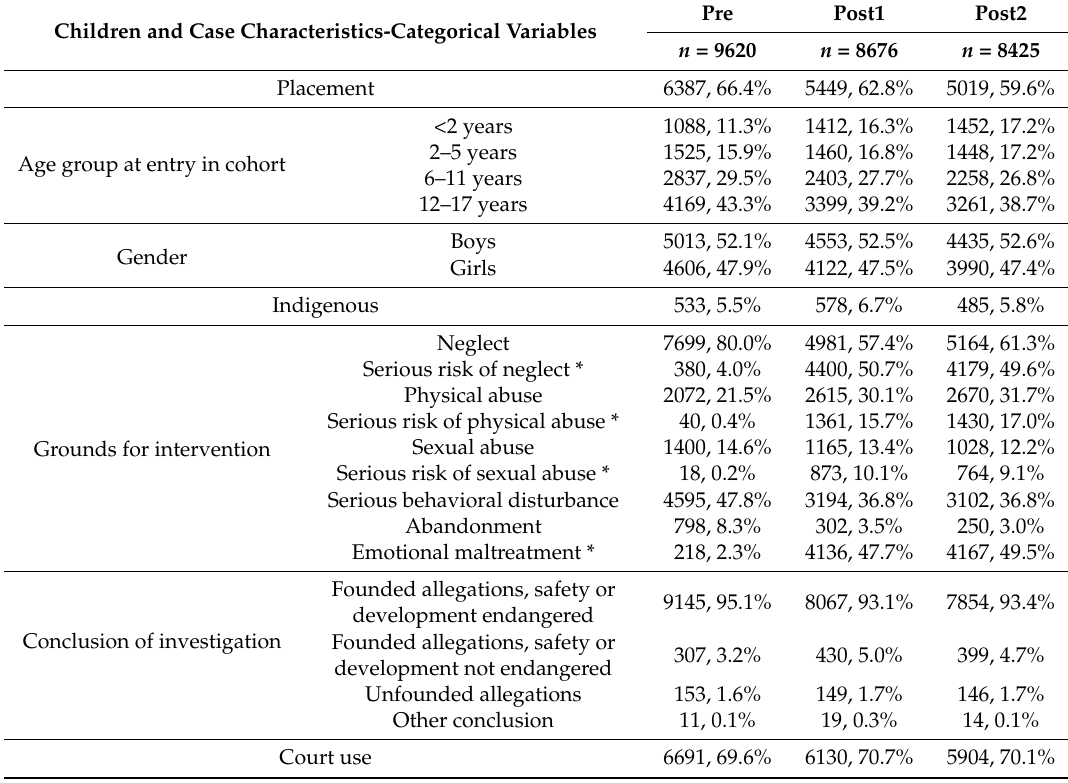
Table 2. Children and case characteristics—Categorical variables.